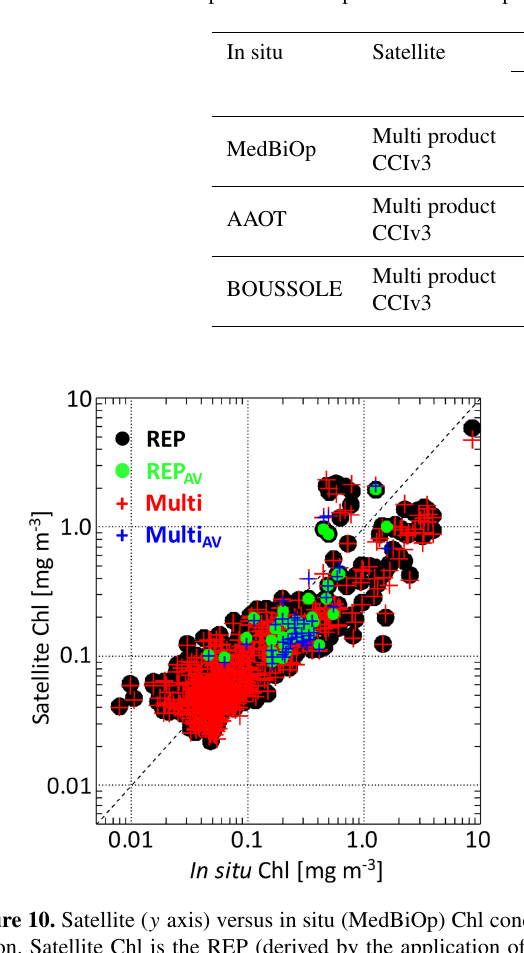
Table 4. Number of matchups used to compute the statistics presented in Fig. 9.